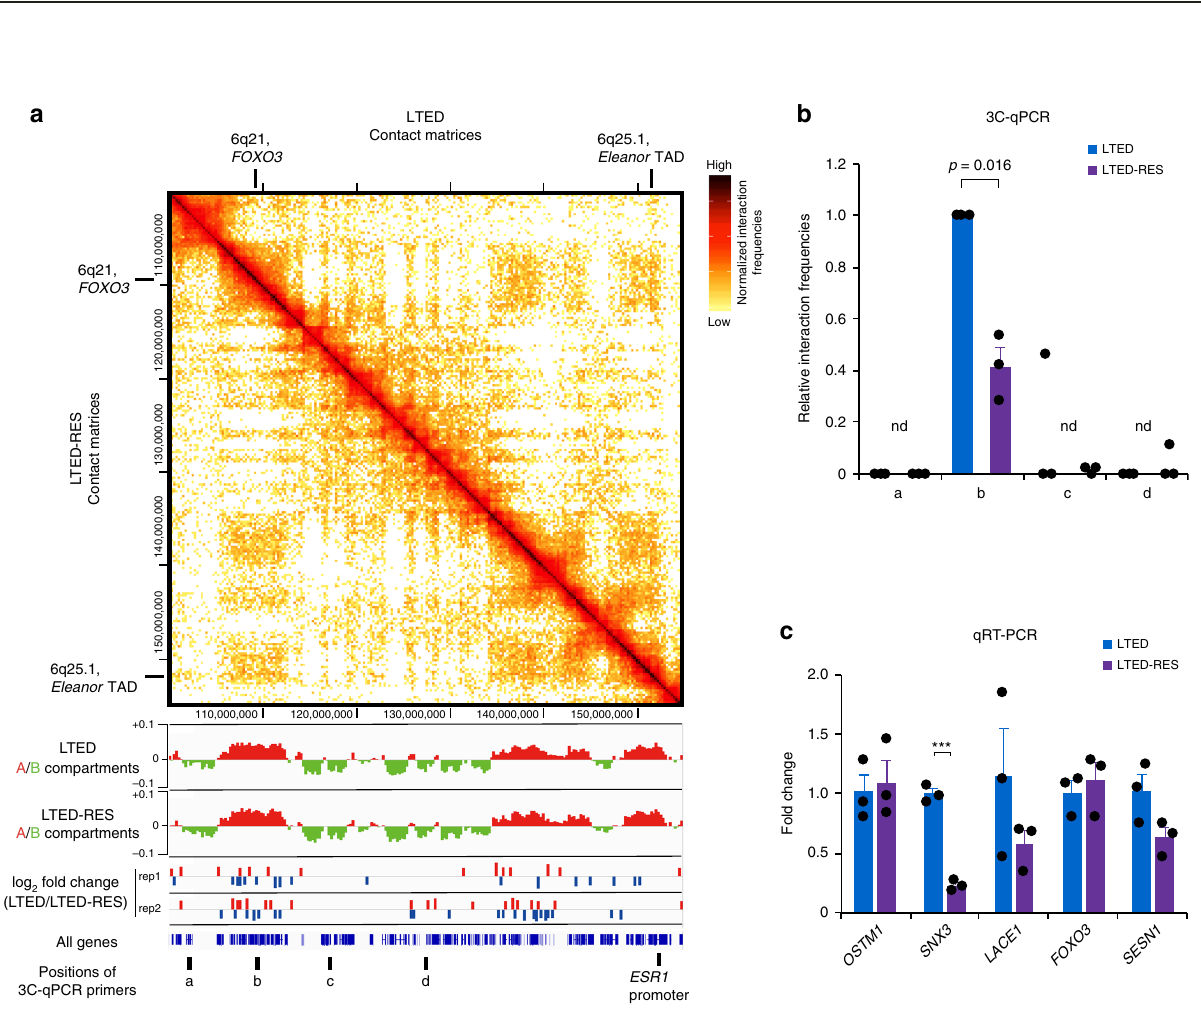
Fig. 2 4C-Seq (chromosome conformation capture combined with high-throughput sequencing) analysis revealed a long-range interaction between ESR1 and FOXO3 genes in long-term estrogen deprivation (LTED) cells. a Alignment of 4C-Seq and A/B compartment pro fi les along the entirety of human chromosome 6 (UCSC genome browser, hg19 assembly). Top: 4C-Seq data showing intra-chromosomal interactions with the ESR1 promoter used as bait (arrowhead). Middle: Distribution of A (red) and B (green) compartments in MCF7 cells 29 . Note the positive correlation relationship between black peaks from 4C-Seq and red peaks representing A compartments. Bottom: distribution of all genes (blue) and genes upregulated in LTED cells (red) 27 . Thick blue bars represent the positions of 3C-qPCR (chromosome conformation capture – quantitative polymerase chain reaction) primers (a – d and the ESR1 promoter) used in this study. Green and red bars represent BAC DNA used as DNA fl uorescence in situ hybridization (FISH) probes in b , c . Bottom: RefSeq genes at the b site. It should be noted that the 4C-Seq pro fi les showed interaction peaks between b site at 6q21 and the ESR1 promoter (bait for 4C). b Representative DNA FISH images of the ESR1 locus (red, using ESR1 p-BAC probe) and b and d sites (green, using b-BAC and d-BAC probes, respectively). The position of each probe is shown in a (green and red bars). Scale bar, 5 µ m. c Quanti fi cation of the DNA FISH analysis in b . Nuclei with overlapping signals at the ESR1 -b site or ESR1 -d site were measured. The frequencies of interaction between the ESR1 and b site increased in LTED cells. P values were calculated using two-tailed Fisher ’ s exact test. d 3Cq-PCR analysis shows interaction frequencies between the ESR1 promoter and a – d sites in MCF7 and LTED cells. Positions of sites a – d are shown in a (blue bars). e Relative expression levels of genes at 6q21 in MCF7 and LTED cells. The MCF7 expression level was set to 1. Data presented in d , e are representative of three independent experiments (mean ± s.e.m.). P values were calculated using unpaired, two-tailed, Student ’ s t test (*** P < 0.001, n.d. = not detected in at least one experiment)